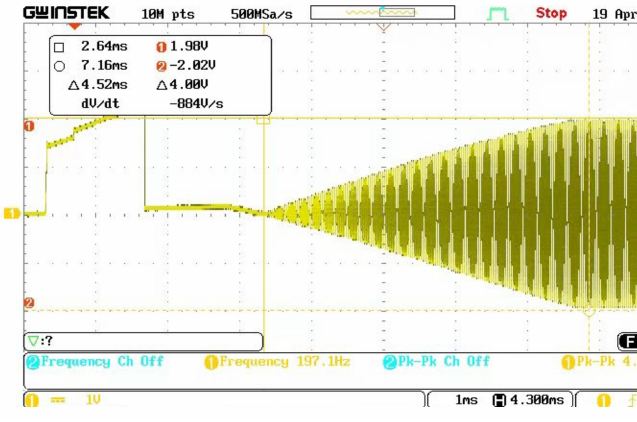
Figure 23. Vibration amplitude of double closed loop.